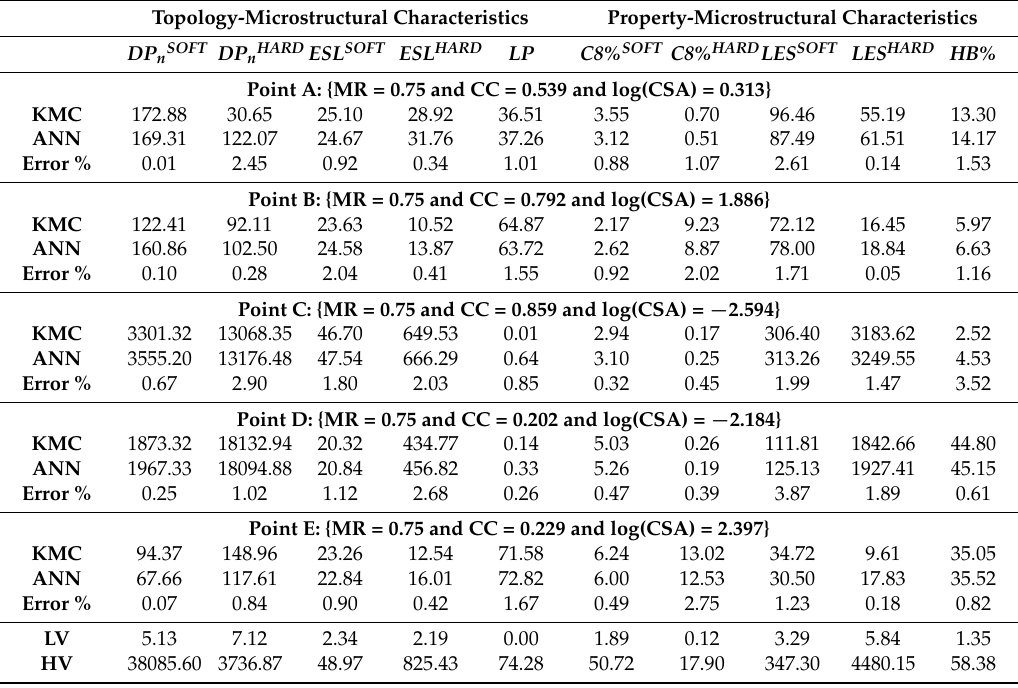
Table 1. Typical OBCs randomly selected in the ‘master plot’ of the IMT and synthesized by the KMC simulator under specified operating conditions together with their topology- and property-related molecular